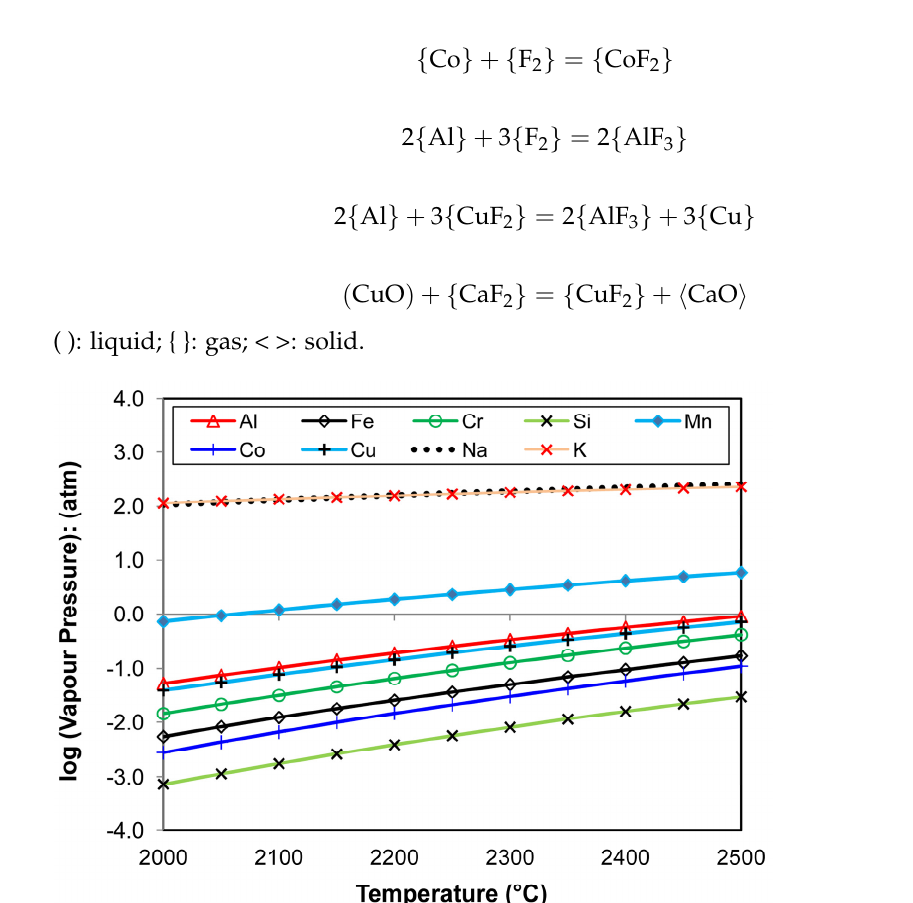
Processes 2023 , 11 , x FOR PEER REVIEW